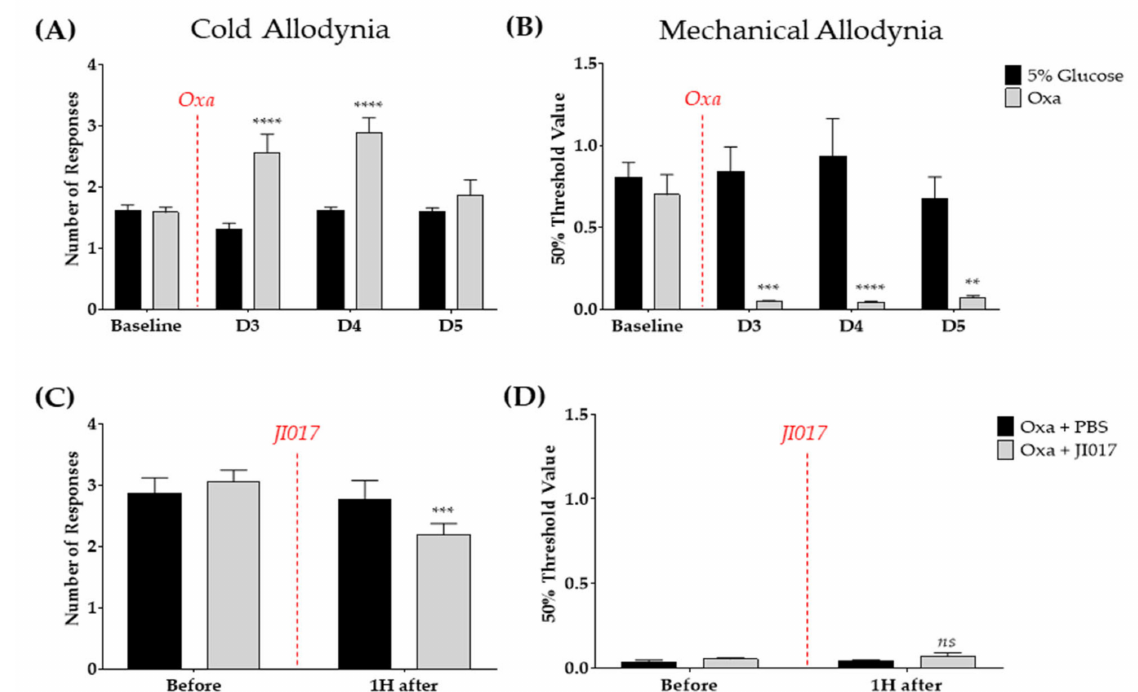
Figure 1. Oxaliplatin-induced cold and mechanical allodynia and the efficacy of JI017 on oxaliplatin-induced neuropathic pain. Changes in the behavioral response to acetone drop ( A , C ) and von Frey ( B , D ) stimulations were observed from day 3 (D3) to D5 after the oxaliplatin injection. On D4 after the oxaliplatin injection, when the cold and mechanical allodynia were significantly induced, JI017 or phosphate-buffered saline (PBS, control) were orally administered to the mice ( C , D ). The 5% glucose (intraperitoneal—i.p.) solution was used as a vehicle of oxaliplatin (6 mg/kg, i.p.) ( A , B ). PBS (per os—p.o.) solution was administered as control for JI017 (500 mg/kg, p.o.) ( C , D ). Baseline—before the administration of oxaliplatin or 5% glucose ( A , B ). Before—before JI017 or PBS treatment 4 days after oxaliplatin injection ( C , D ). Oxa—oxaliplatin. 5% glucose: n = 6, Oxa: n = 6, Oxa + PBS: n = 5, Oxa + JI017: n = 6. ns—non-significant, ** p < 0.01, *** p < 0.001, **** p < 0.0001 vs. 5% glucose or Oxa + PBS with two-way ANOVA followed by Sidak’s post-test for multiple